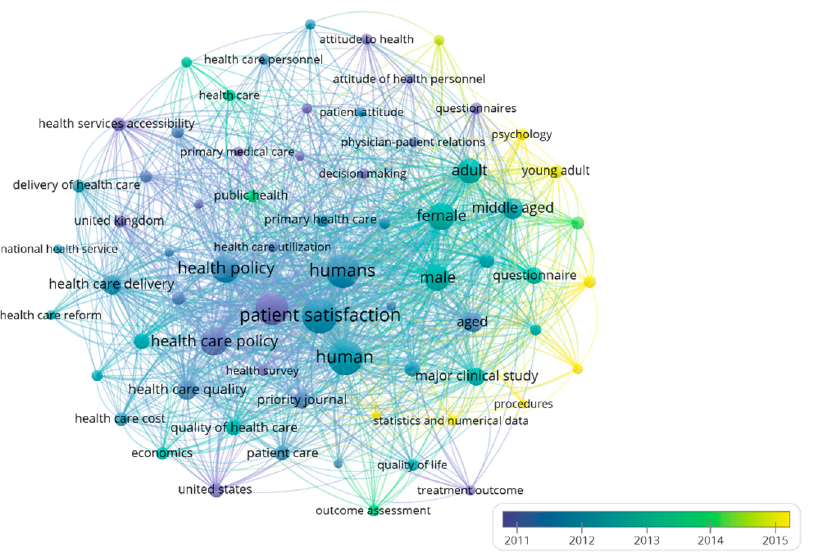
Figure 9. Evolution of leading keywords network based on co-occurrence (1954–2020). Own elaboration.